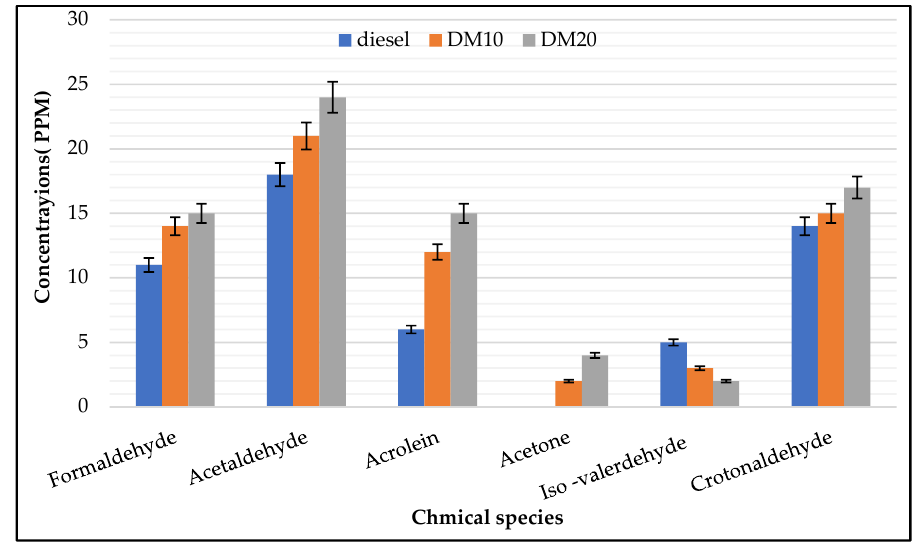
Figure 6. Emissions concentration with carbonyl compounds speciation (4 bar NMEP).